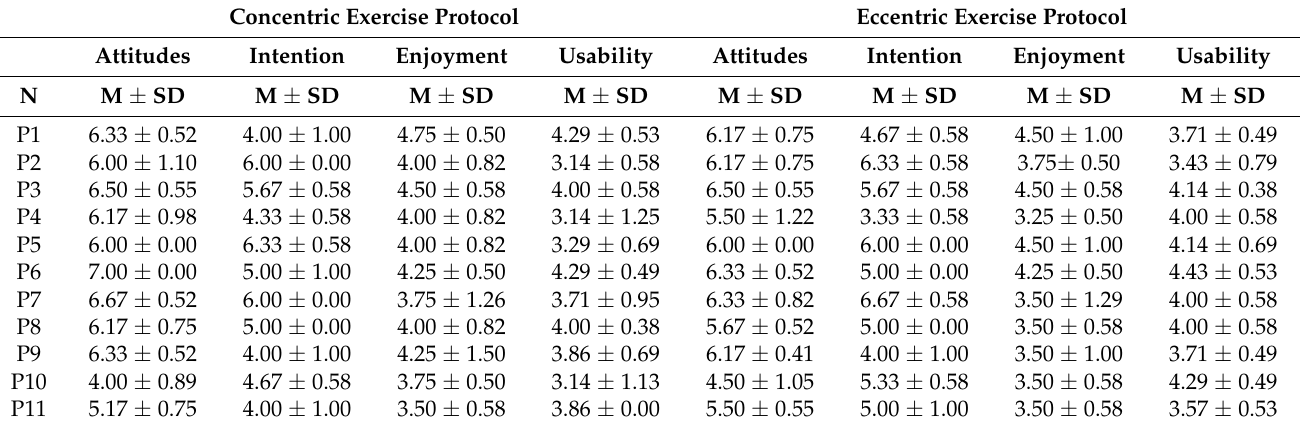
Table 2. Descriptive statistics (means and standard deviations) and Shapiro-Wilks test for checking normality in both exercise protocols (concentric and